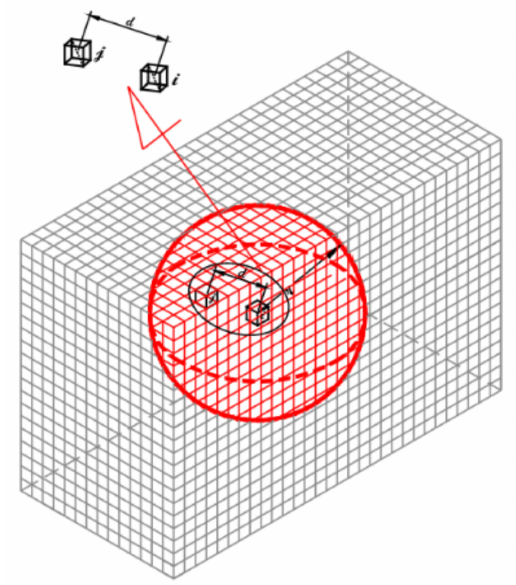
Figure 1. Spatial